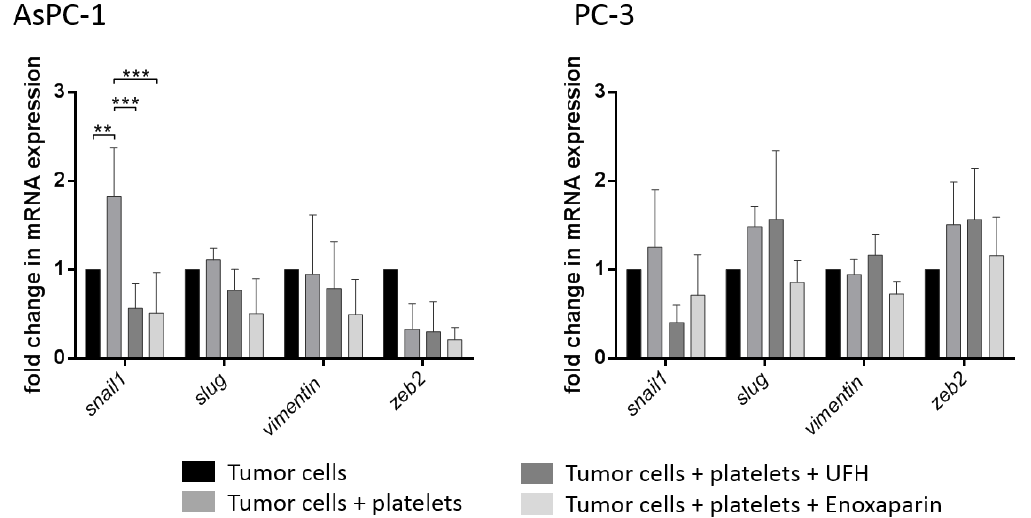
Figure 4. Relative fold change in mRNA expression in AsPC-1 or PC-3 cells treated with buffer, platelets, platelets and UFH, or platelets and enoxaparin for 72 h, respectively. Values are normalized to Gapdh, β -actin and RPL13 expression. Statistical significance was evaluated by two-way ANOVA test. Data are means of at least n = 3 ( ± SD), asterisks indicate statistical significance: ** p ≤ 0.01; *** p ≤ 0.001.